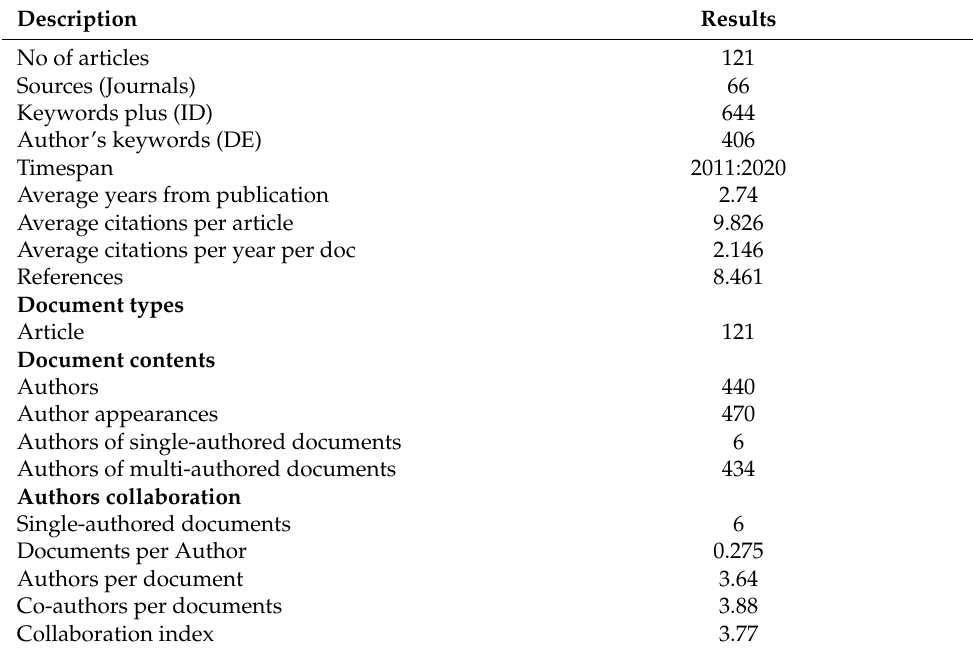
Table 3. The primary information about the data utilized in this